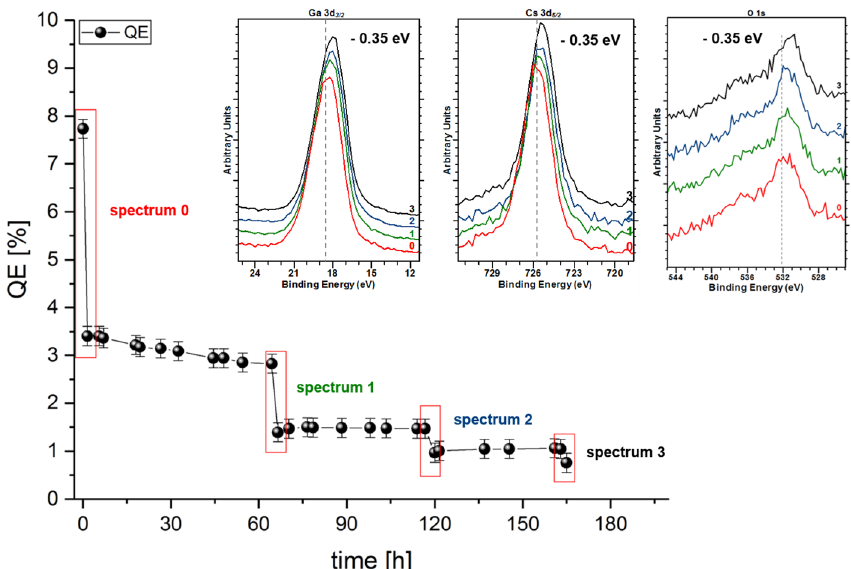
Figure 5. The QE decay of the p-GaN:Cs photocathode (sample A) and the Ga 3d 3/2 , Cs 3d 5/2 , and O 1 s photoemission spectra at different times during its